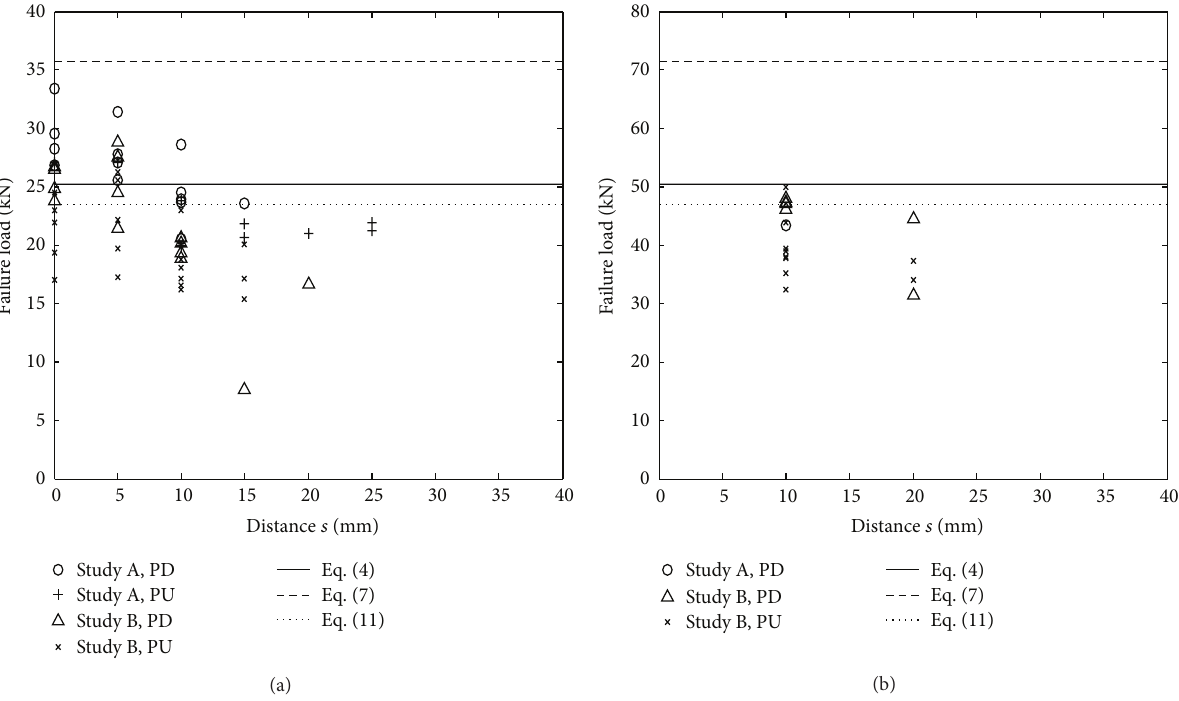
Figure 15: Comparison between theory and experiments for horizontal cracking of a bottom rail. (a) Specimens with single-sided sheathing and (b) specimens with double-sided sheathing. PD = pith downwards, PU = pith upwards.